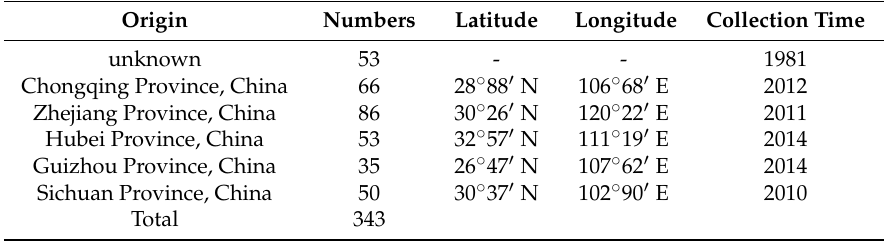
Table 1. The origin areas of cypress breeding